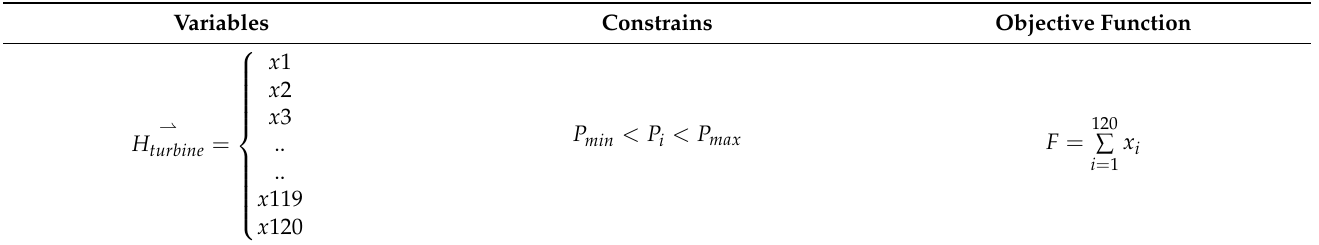
Table 3. The optimization